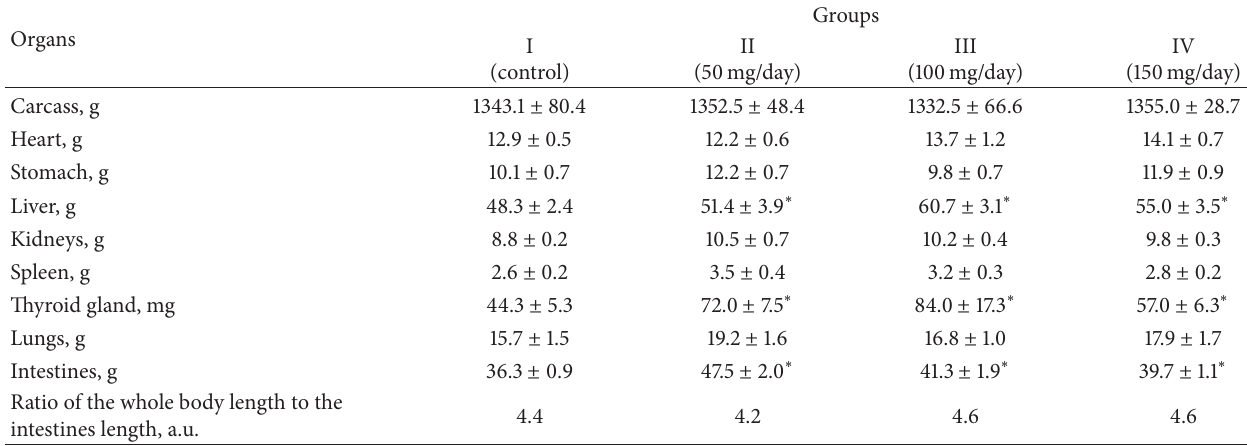
Table4:Majorparametersoftheinnerminksorganstakenfromthecontrol(I)andexperimental(II–IV)animalgroups(receivedphenozan).